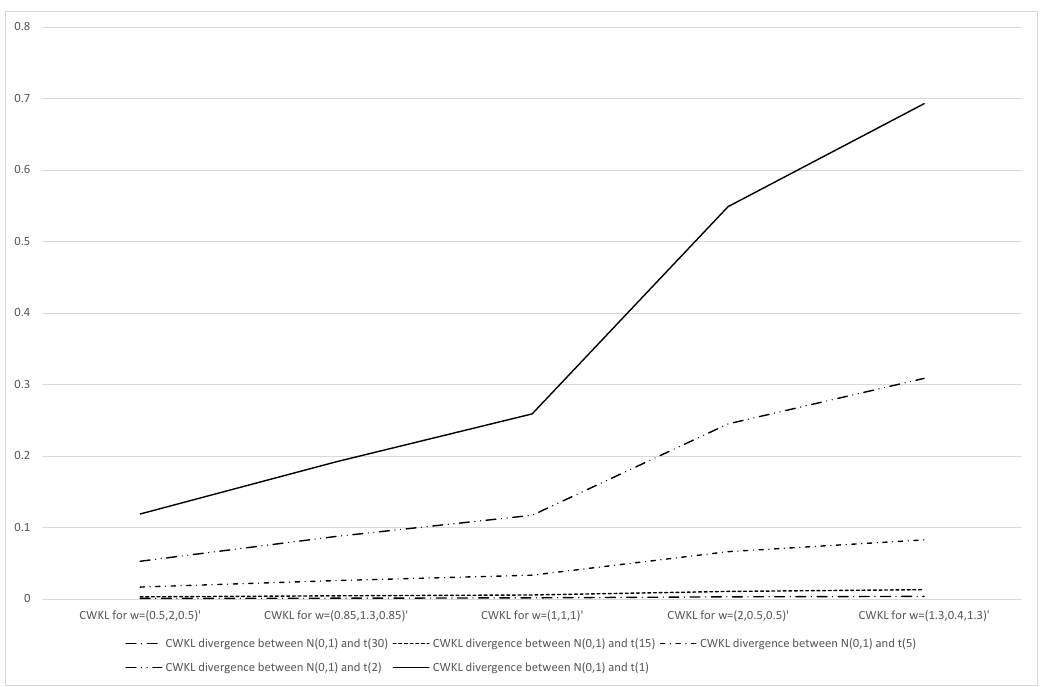
Figure 3. CWKL divergence between Standard Normal and various Student’s t-distributions.